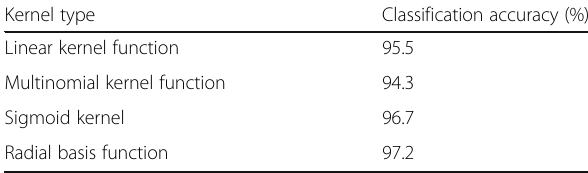
Table 1 SVM performance using different kernel functions Kernel type